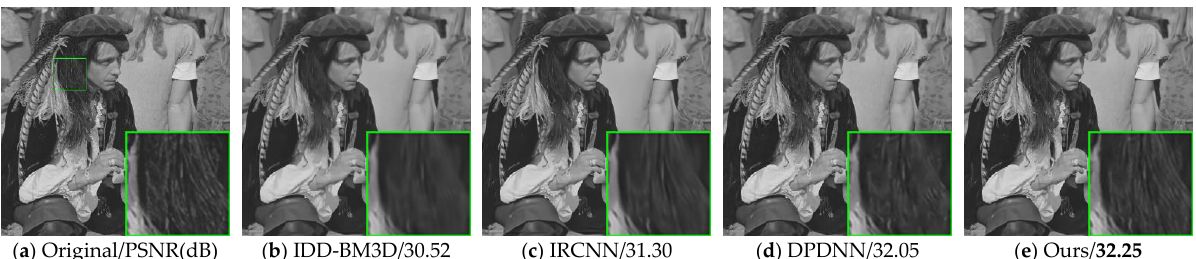
Figure 6. Image deblurring results on Boat in Figure 3 with 17 × 17 motion blur kernel and σ n = 2.55. ( a ) The original image. ( b ) The result of EPLL. ( c ) The result of IRCNN. ( d ) The result of DPDNN. ( e ) Our result.